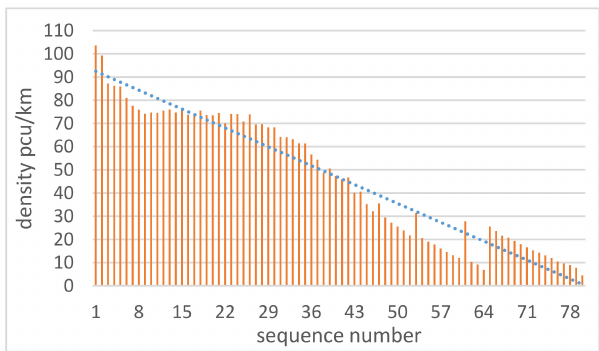
Figure 4. Average speed.